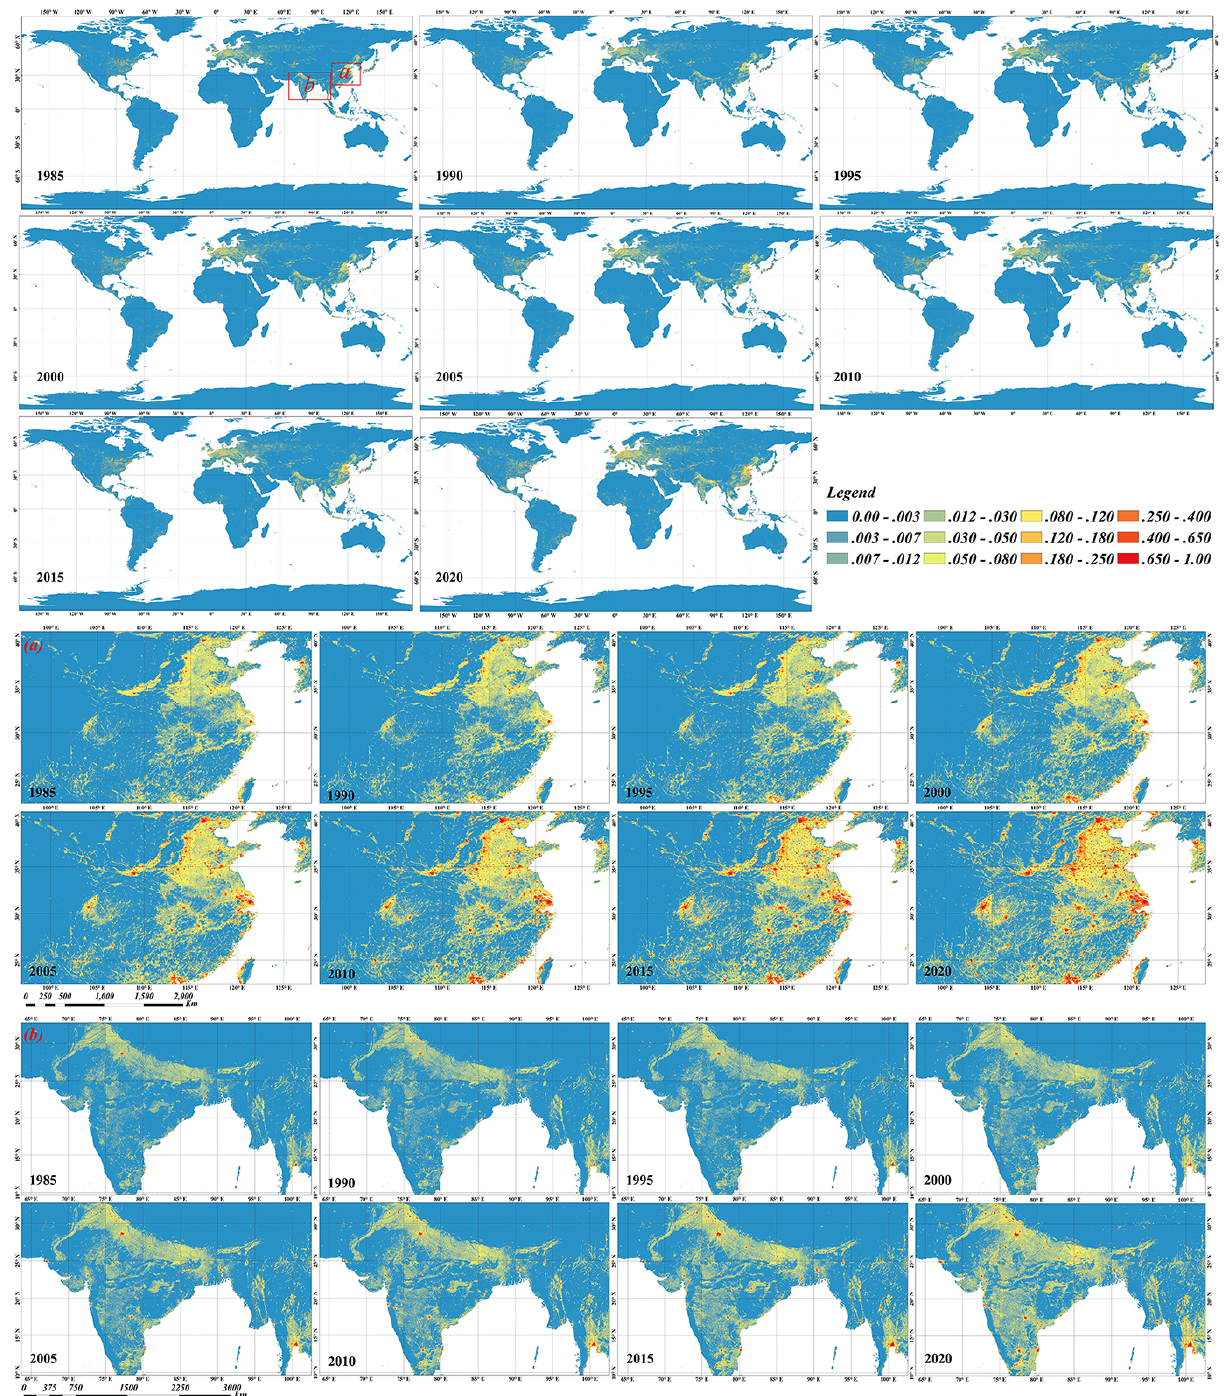
Figure 5. The spatial distributions of time-series global 30m impervious-surface results and two local enlargements in China and India from 1985 to 2020 with intervals of 5 years. Each pixel represents the fraction of impervious surface within each 0 . 05 ◦ × 0 . 05 ◦ spatial grid.